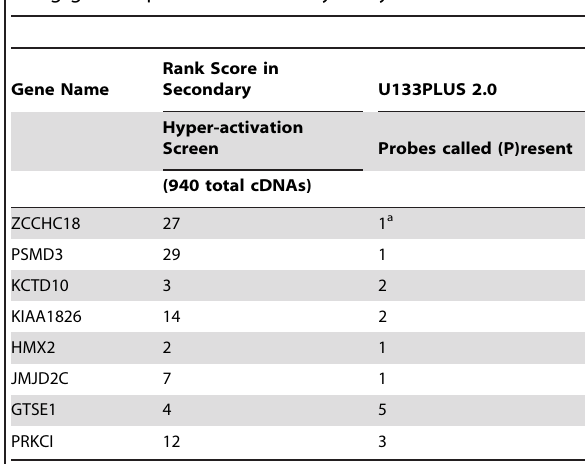
Table 1. Rank score of selected genes from the secondary hyper-activation screen and their expression in HEK293T cells using gene expression microarray analysis.